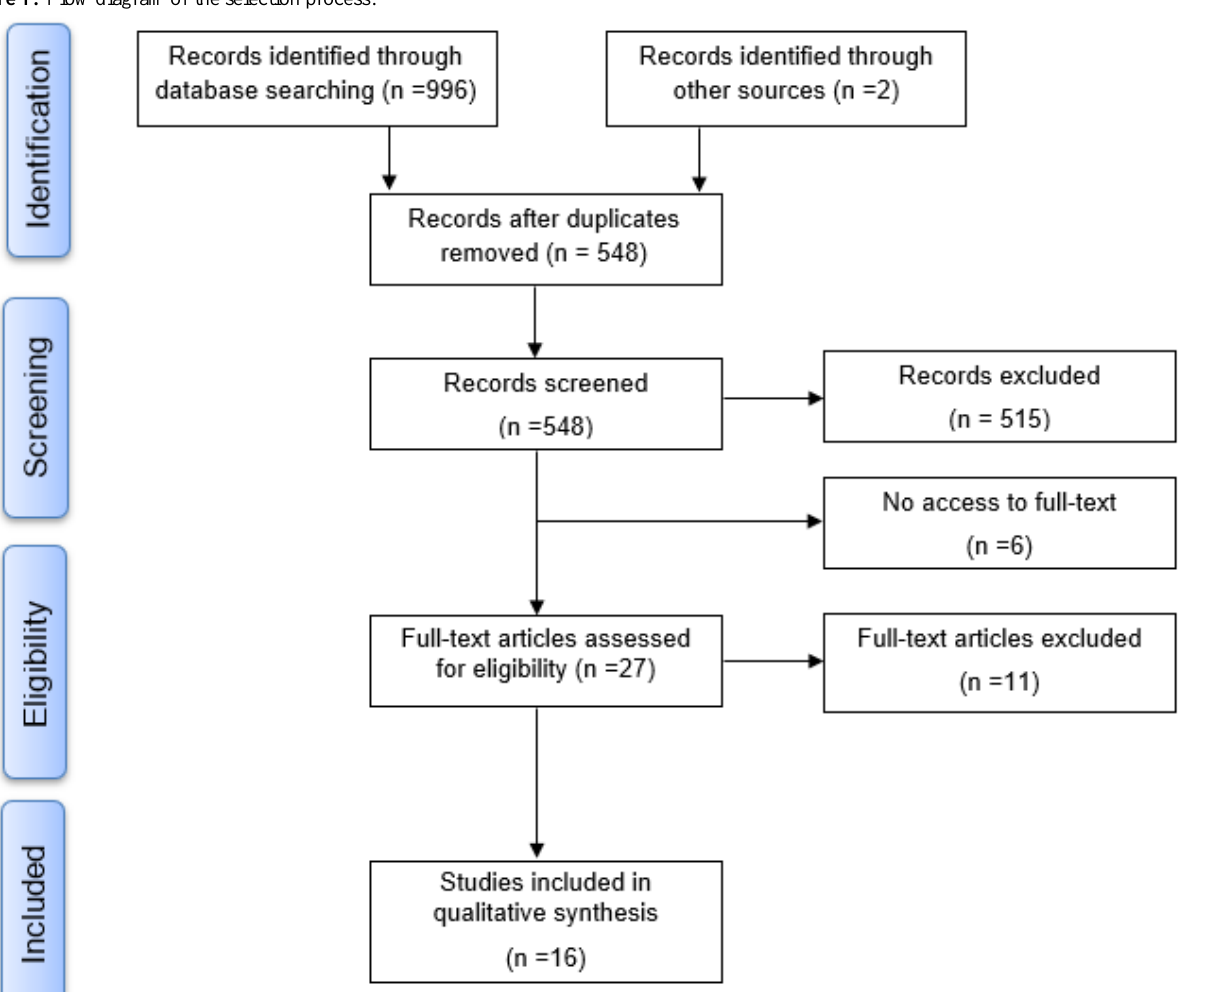
Figure 1. Flow diagram of the selection